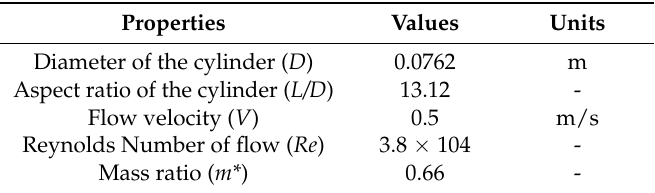
Table 1. Properties of the elastically mounted cylinder model.